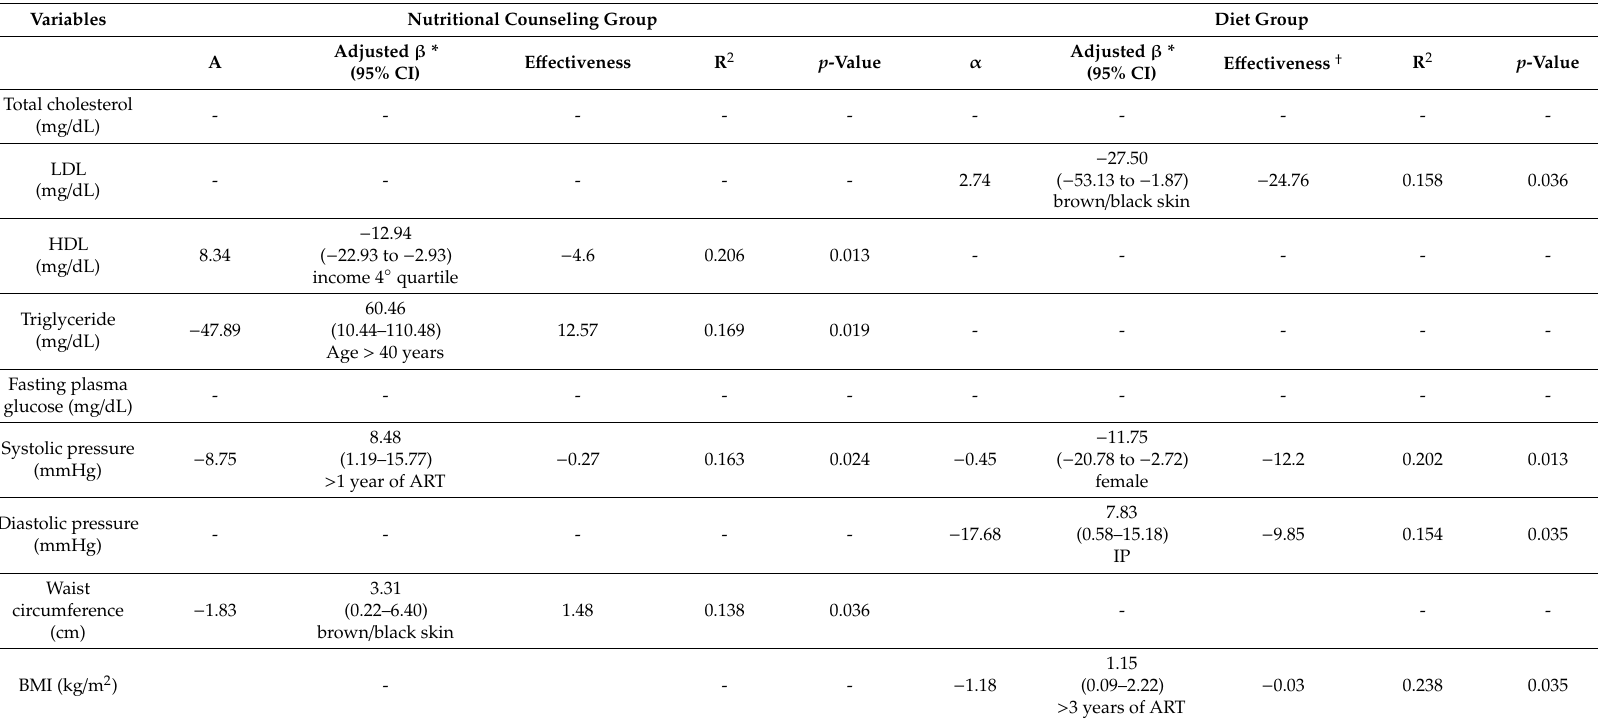
Table 4. Multiple linear regression of the e ff ectiveness of each nutritional treatment on cardiometabolic outcomes.